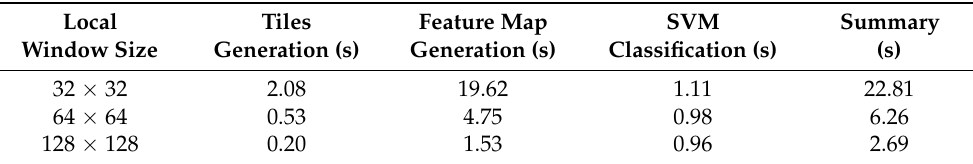
Table 2. Time consumed for extracting effective monitoring regions of ocean waves with different local window